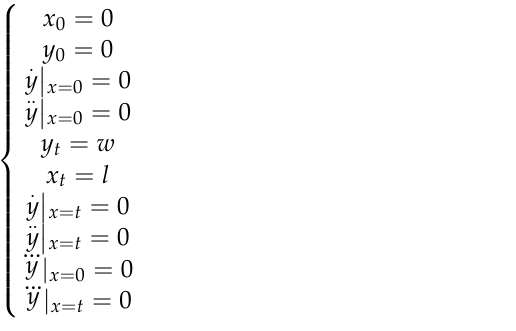
x v Figure 3. 2-DOF vehicle dynamic model.